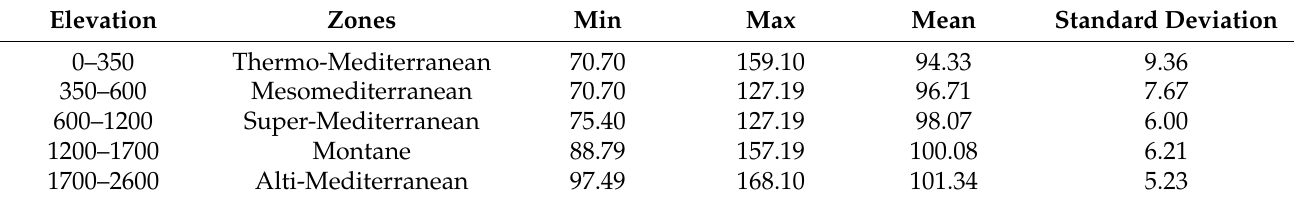
Table 6. Zonal Statistics for WLDI according to the various zones